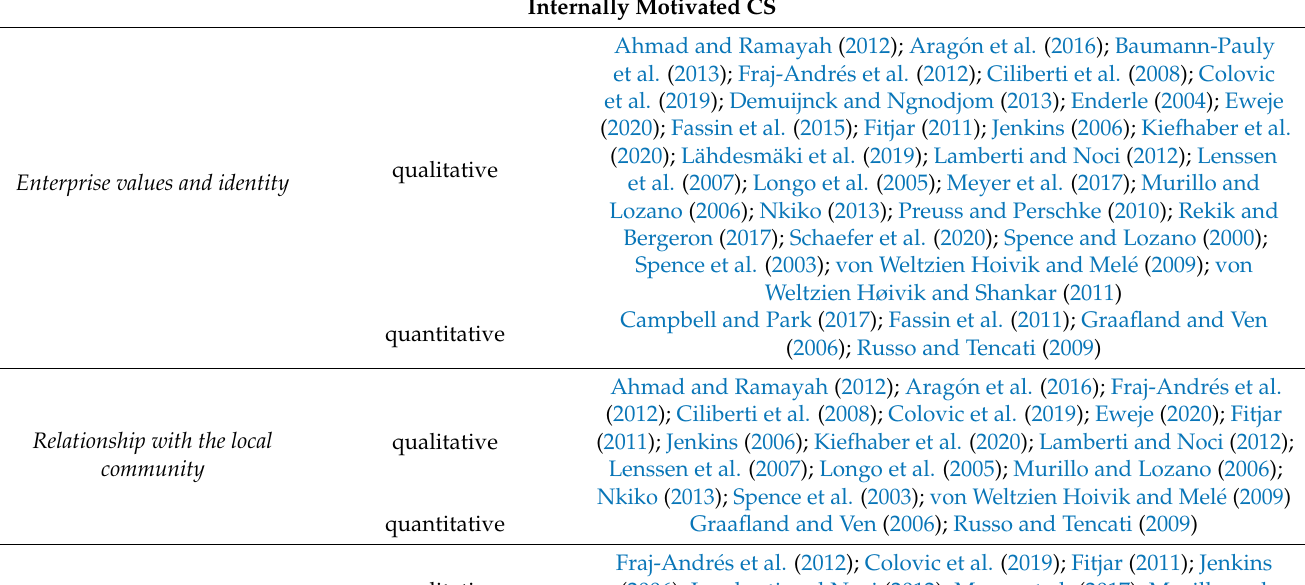
Table 1. Studies structured by discussed motives for CS and